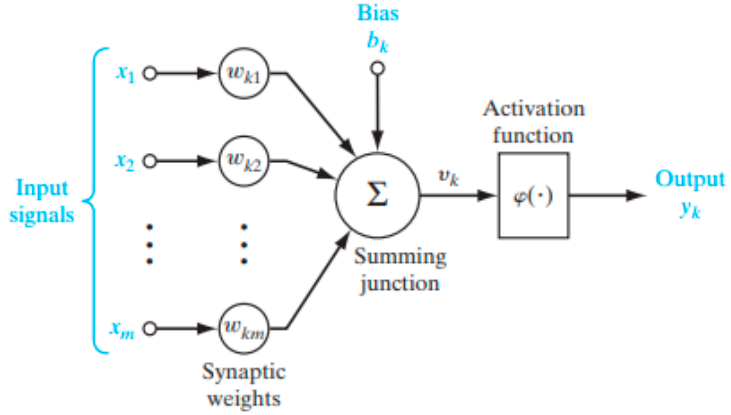
Figure 12. Nonlinear Neuron Model.